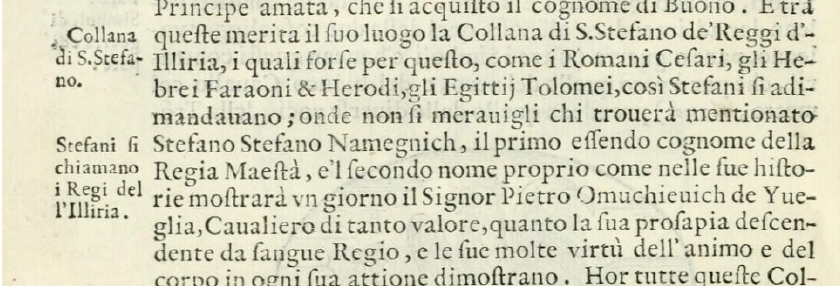
Figure 9. Passage from the Delle Imprese p.10.b.1.